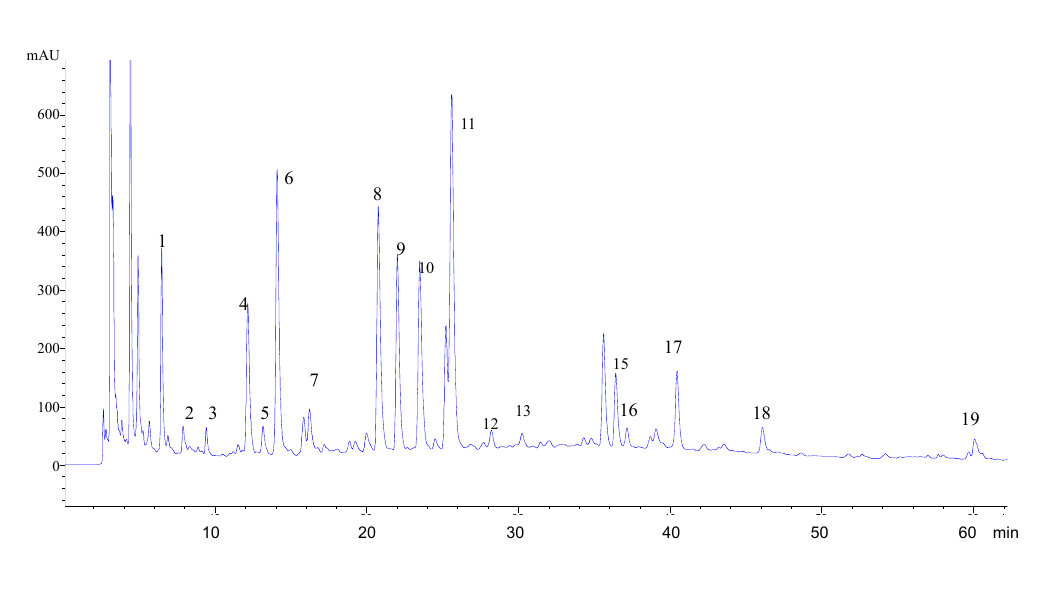
Figure 2. HPLC fingerprint of the A. scopariae extract . Nineteen “common peaks” were determined with respect to the common RRT and RPA in three batches of A. scopariae